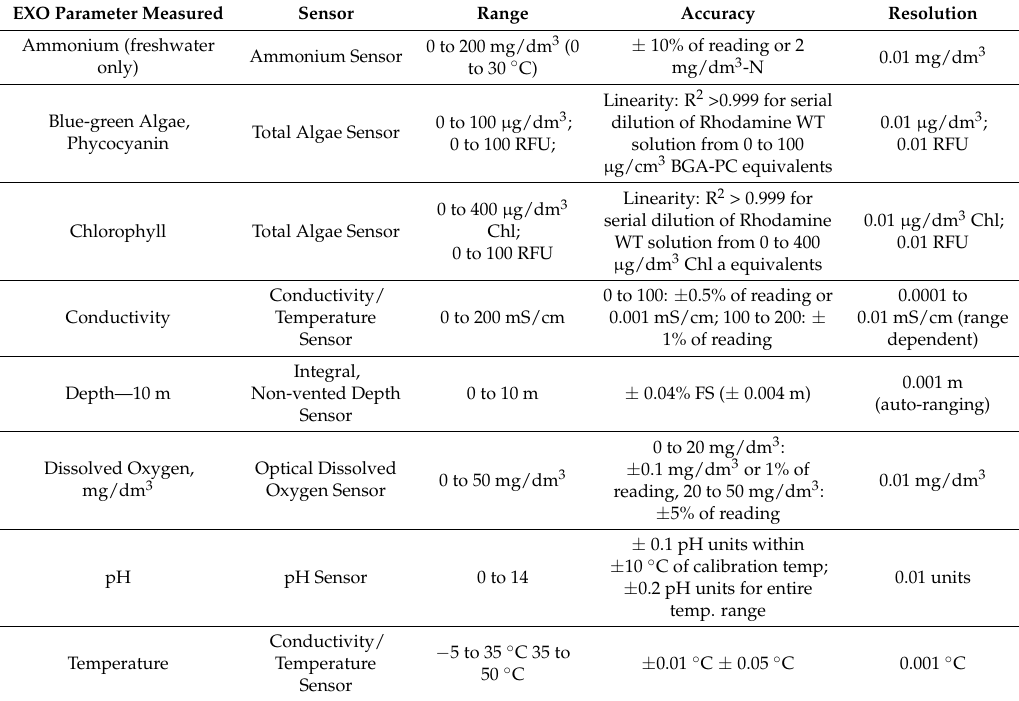
Figure 1. Localization and photography of the stationary system for water quality measurements, installed on the Sulejow Reservoir. Table 1. Characterization of EXO measured parameters (https://www.ysi.com/EXO2) [11].